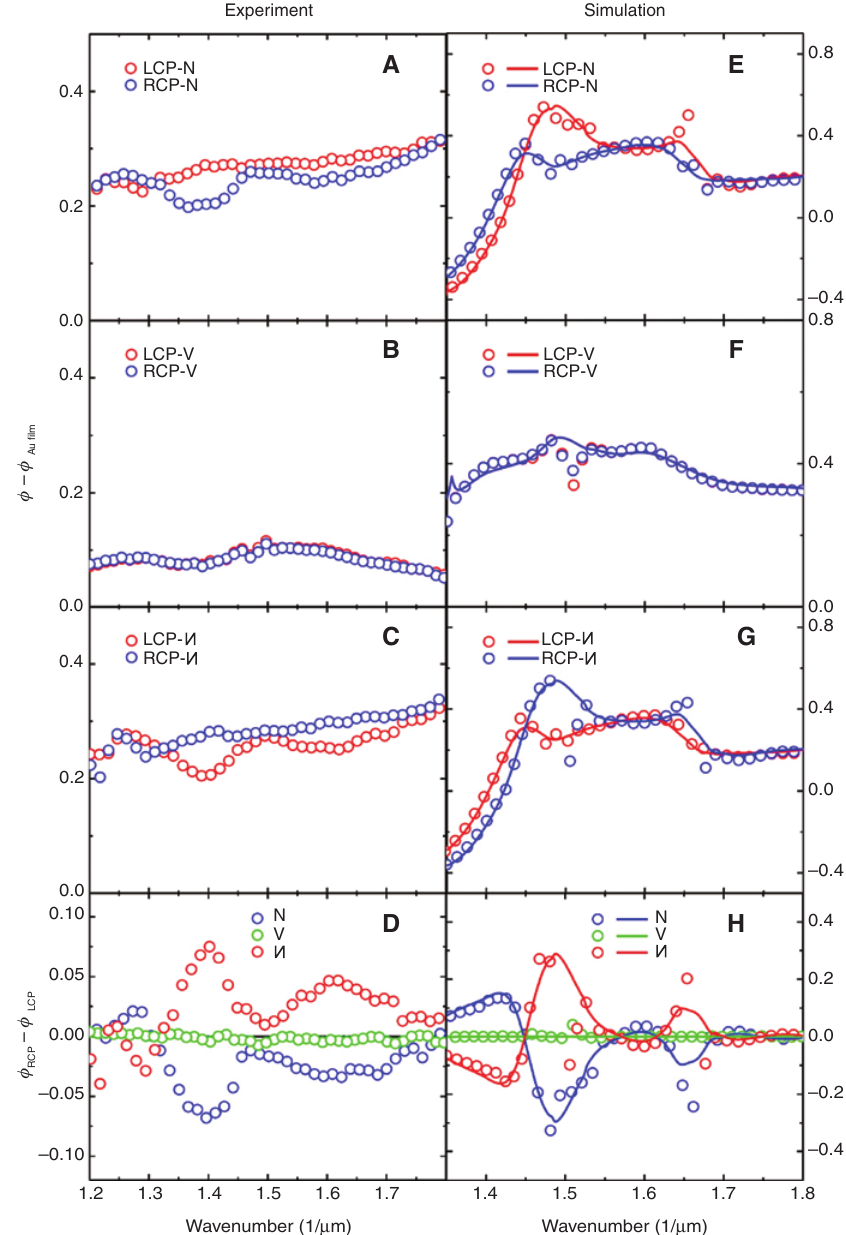
Figure 5: Reflection phase and circular phase-dichroism. (A)–(C) Reflection phase of LCP (red circles) and RCP (blue (circles) incidence light with respect to Au film, i.e. φ − φ (green circles) and И -type (red circles) complementary Au sawtooth metasurfaces, respectively. (D) Reflection phase difference, φ И - (blue circles), V - (green circles) and И -type (red circles) complementary Au sawtooth metasurfaces. (E)–(H) Corresponding results from CST = 0.2. Symbols are results obtained using the peak/trough fitting method and solid curves are calculated using Eq. simulations using r G